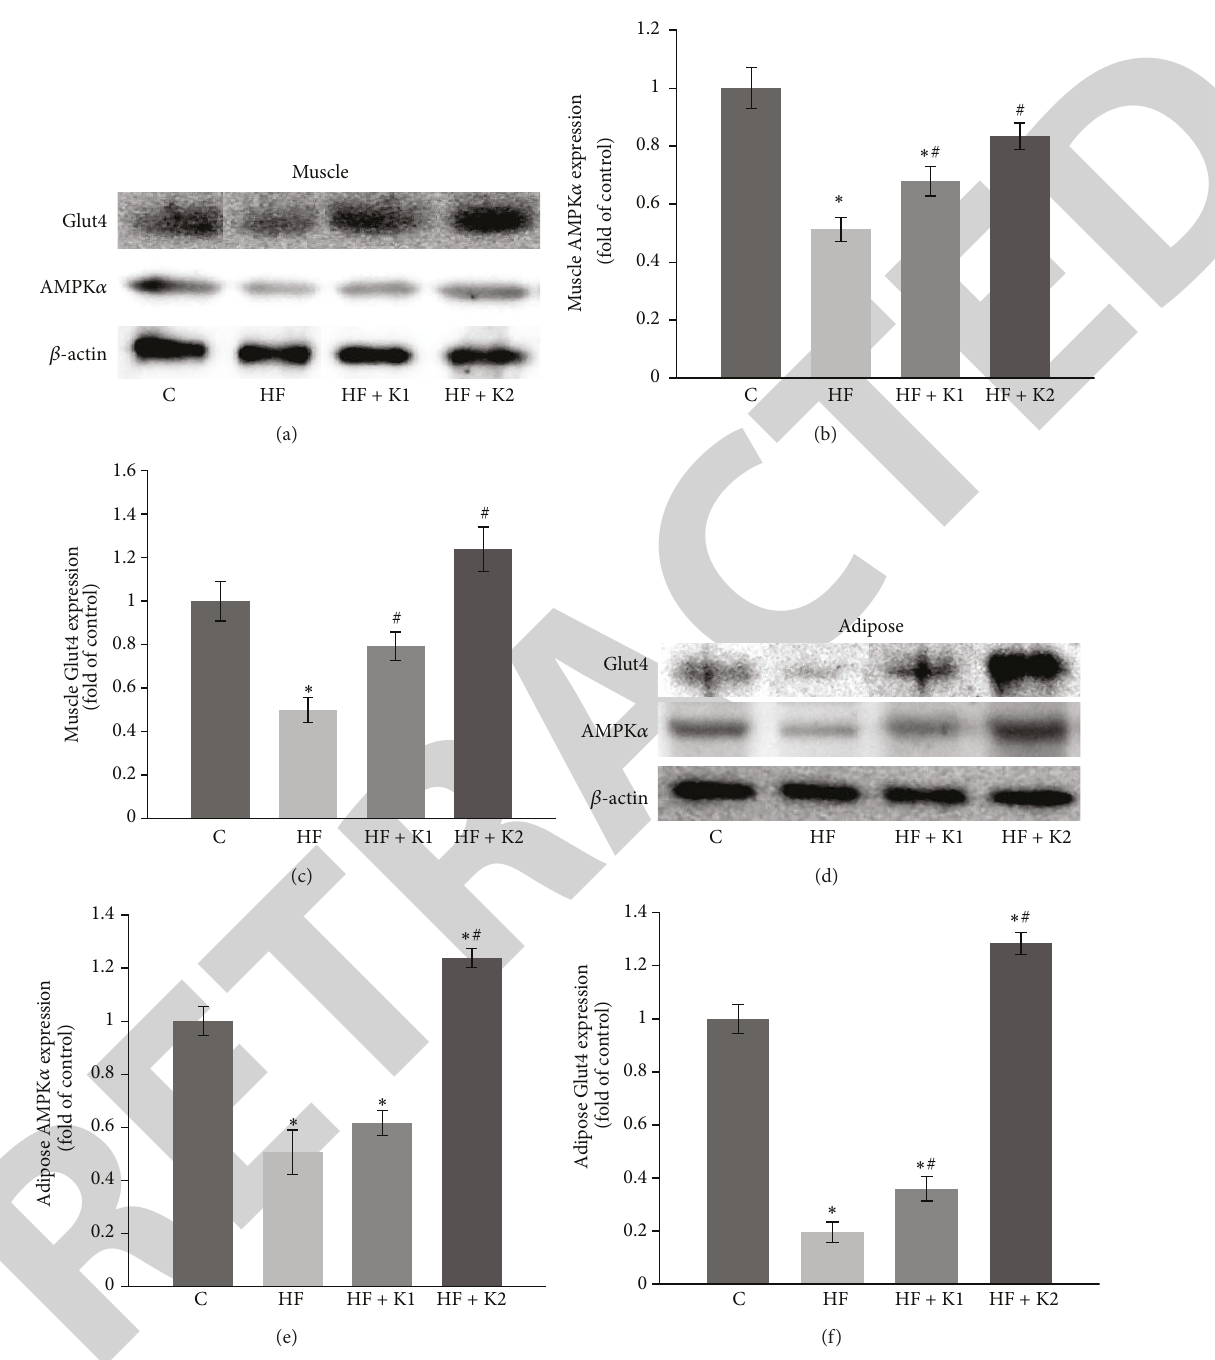
Figure 3: Kaempferol supplementation completely prevented the HF diet-induced decreases in AMPK 𝛼 and Glut4 protein expression in skeletal muscle and adipose tissues of obese mice. At the end of feeding experiment, AMPK and Glut4 protein levels in whole cell lysates of skeletal muscle ((a)–(c)) and adipose tissue ((d)–(f)) of mice were measured by immunoblotting and normalized to 𝛽 -actin content. Values are means ± SE from 4 mice per group. ∗ 𝑝 < 0.05 versus standard diet-fed mice (C); # 𝑝 < 0.05 versus HF-fed mice. C: standard diet; HF: high-fat diet; HF + K1: HF diet containing 0.01% kaempferol; HF + K2: HF diet supplemented with 0.05%